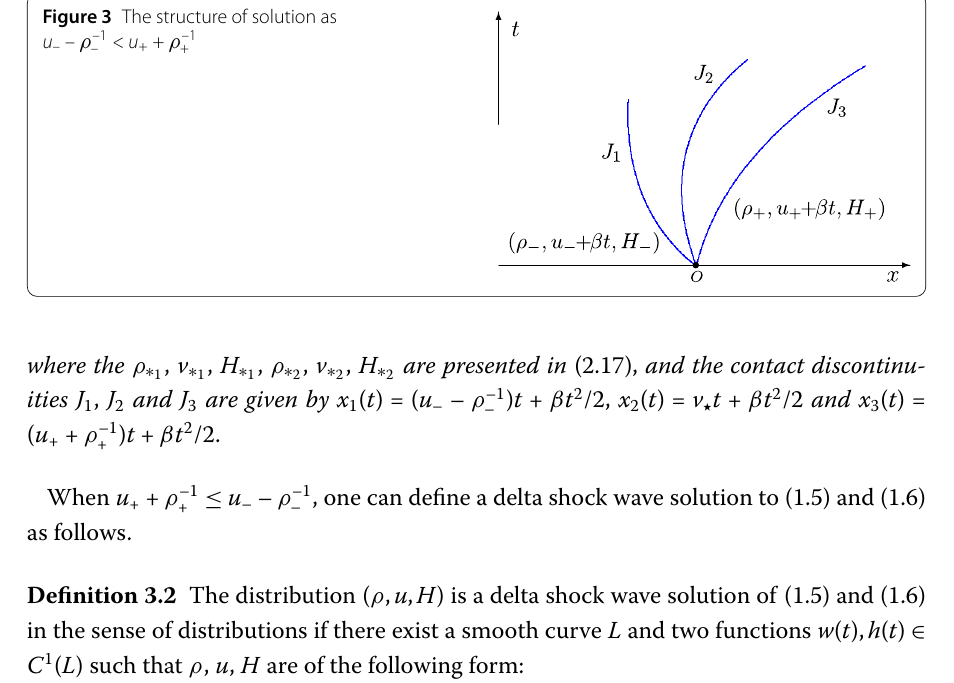
Figure 3 The structure of solution as